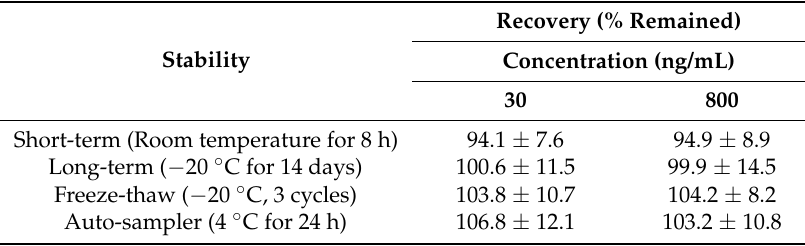
Table 2. Stability of ATBC in rat